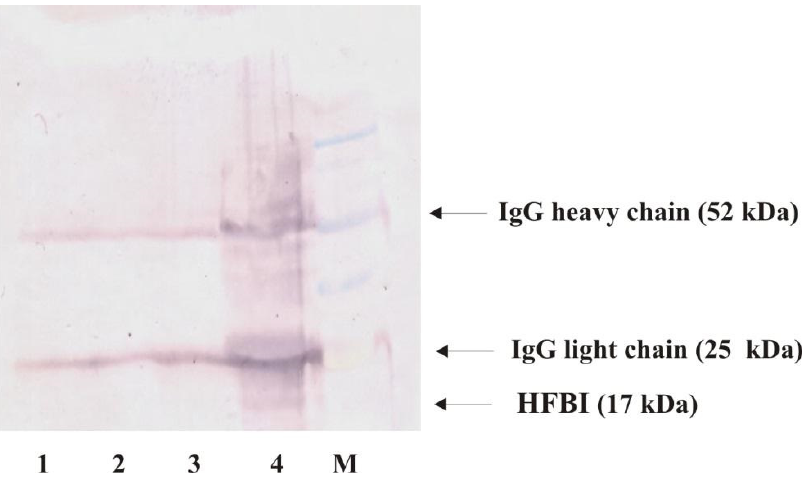
Figure 5. Western blot analysis of hydrophobin. Proteins were immunoprecipitated using anti-HFBI antibody, and resulting pellets were washed and subjected to SDS-PAGE/Western blot analysis. Lane 1: liquid medium, lane 2: T. viride GZ1 culture, lane 3: liquid medium with PET, lane 4: T. viride GZ1 culture with PET, and M: molecular mass standard (BluEasy Prestained Protein Marker, Nippon Genetics, Dürren, Germany). All analyzed media/cultures were incubated for 3 months. Arrows indicate IgG heavy (52 kDa) and light (25 kDa) chains and protein that corresponds to HFBI (17